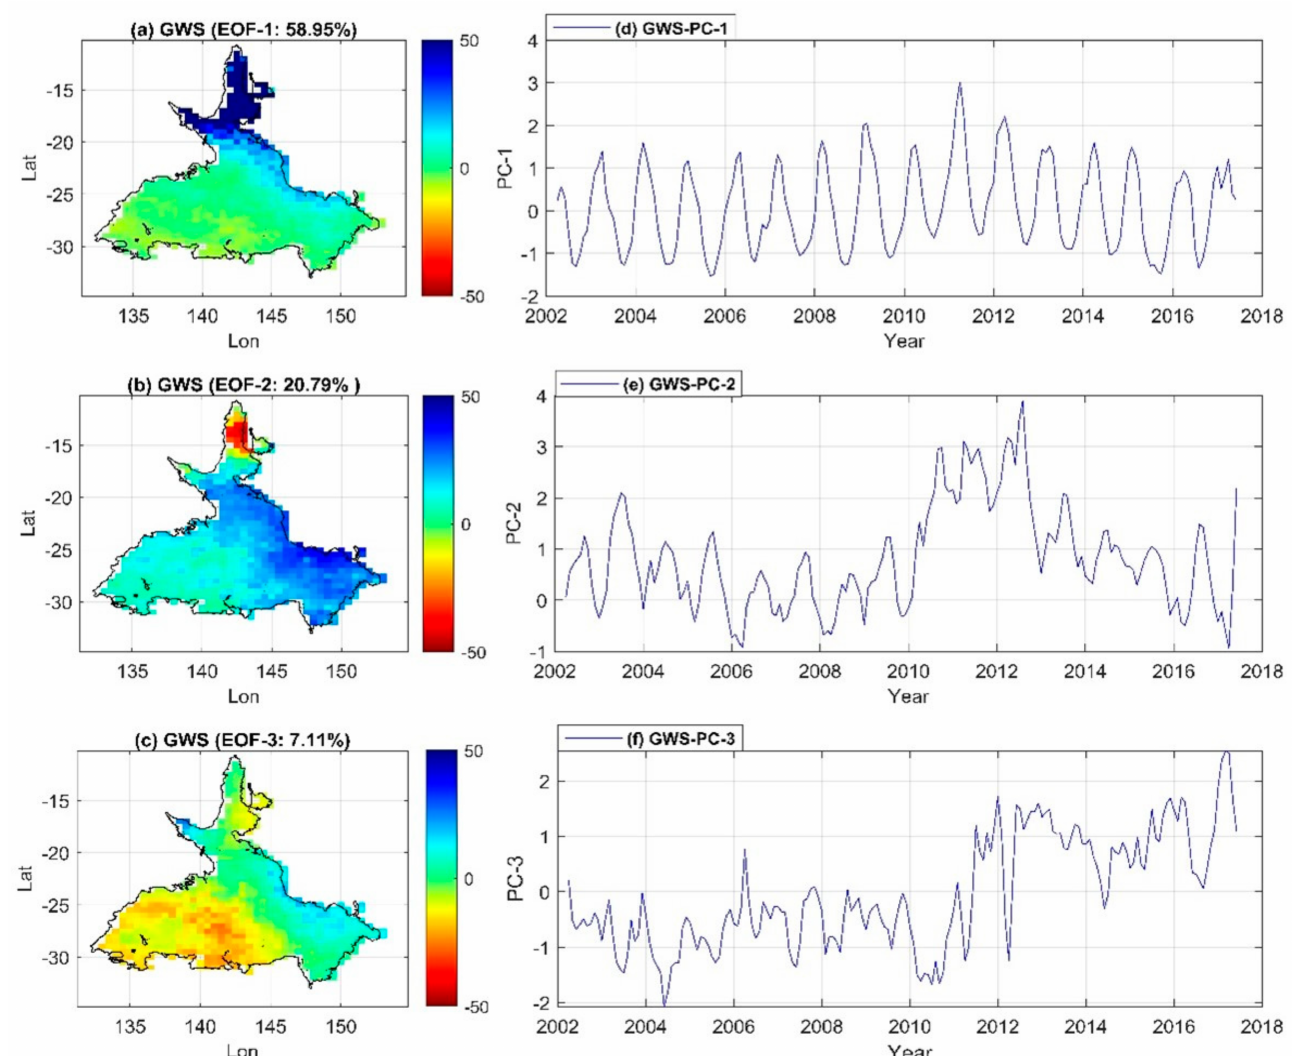
Figure 5. Spatio-temporal patterns of variations in groundwater storage variations (2002–2017) over the GAB using principal component decomposition. The amplitudes on the y-axis (lower row) are normalized using standard deviations (unitless). The upper row highlights the corresponding spatial patterns (unit: mm) to these temporal patterns. The collective interpretation of temporal patterns in ( d – f ), and their corresponding spatial patterns in ( a – c ) provide details of the variations in terrestrial water